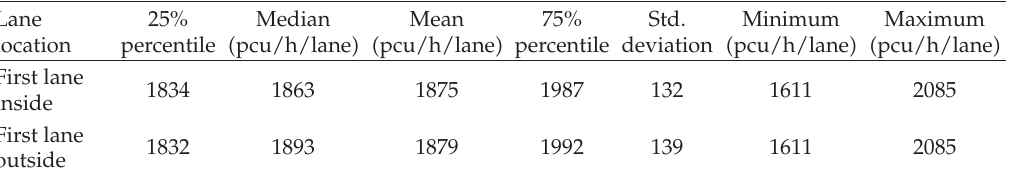
Table 5: The statistics of flow rate after